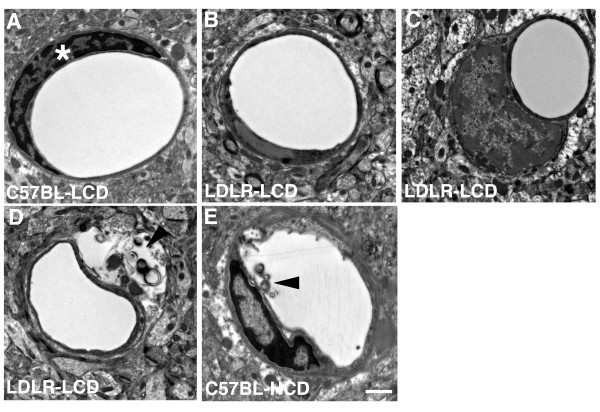
Ultrastructural analysis of the cerebral microvasculature in mice fed low- or high- cholesterol diets. Transversely sectioned capillaries are shown from the entorhinal cortex of C57BL/6J or LDLR-/- mice fed low- (LCD) or high- (HCD) cholesterol diets for 4 months. The microvessel in panel A from a C57BL/6J mouse fed a LCD exhibits a circular lumen, an intact endothelial cell, and smooth capillary walls. Note the altered chromatin structure in the endothelial cell nucleus in panel B, and the swollen endothelial cell nucleus in panel C. A normal endothelial cell nucleus is indicated by an asterisk in A. Arrowheads indicate an expanded extravascular space containing amorphous debris (D), or luminal degeneration (E) in an LDLR-/- mouse fed a LCD (D), or a C57BL/6J mouse fed a HCD (E). Scale bar = 1 μm.